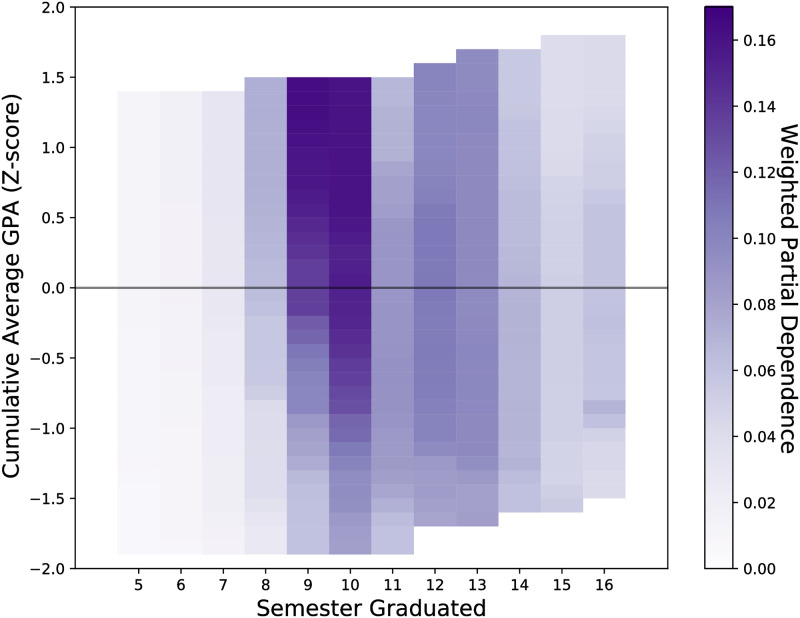
The partial dependence per semester for the cumulative average GPA a student has obtained.The stronger the partial dependence, the more contribution that the cumulative average GPA has on the predicted probability that a student will graduate in the given semester. The partial dependence has been weighted by the per semester F1 score. Having a far above average GPA is a major contribution to graduating if a student graduates between semesters 9 and 10. This is likely due to these students never failing a course and having a high commitment to their chosen major.